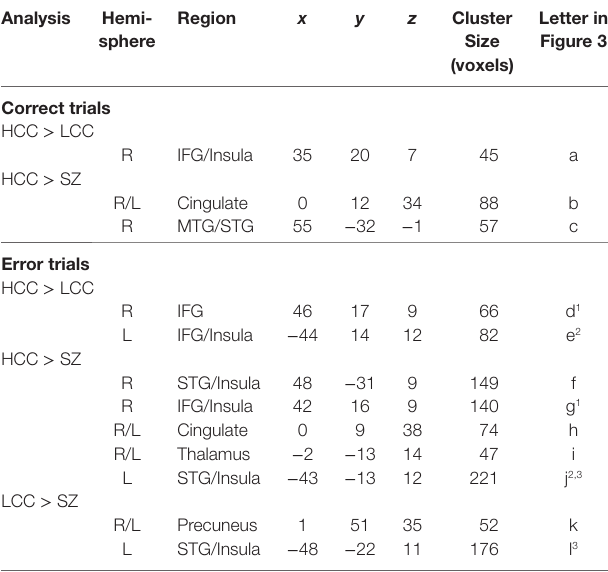
Table 2 | Mixed-effects multilevel analysis (MEMA) results. analysis hemi- region cluster sphere